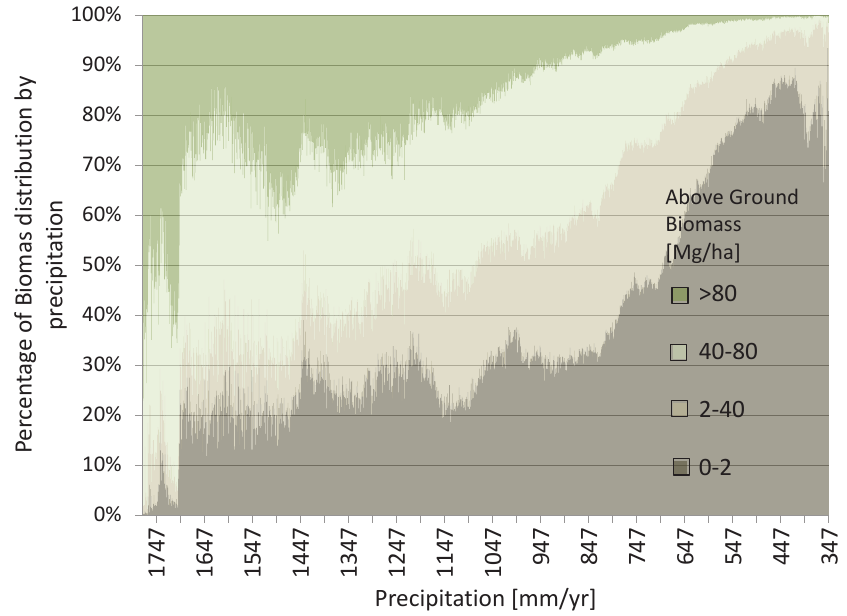
Figure 6. Fraction of biomass in given ranges as a function of mean annual precipitation.